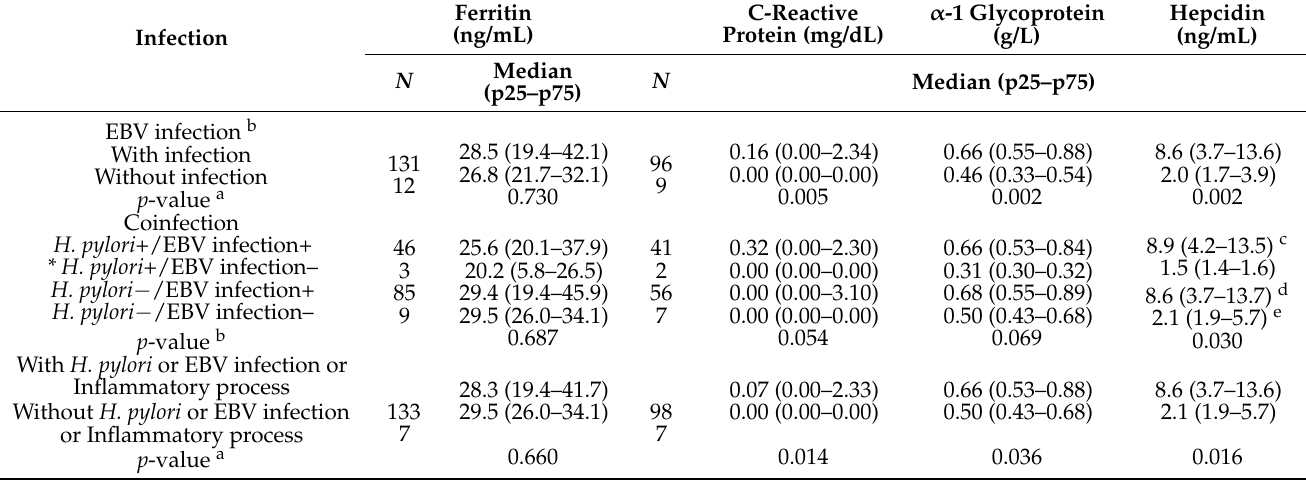
Figure 1). The ferritin concentration was not different. Hepcidin, CRP, and AGP levels were higher in EBV carrier children, and/or with H. pylori infection and/or in children with an inflammatory process, than in children non-infected or without an inflammatory pro- cess. Figure 2 shows that all the markers measured of EBV infection: VCA-IgG (R = 0.302, p < 0.001), EBNA1-IgG (R = 0.244, p = 0.011), and EA-IgG (R = 0.345, p = 0.011) had a positive correlation with the hepcidin concentration. We did not see significant correlations between EBV antibodies and CRP and AGP. The only other positive correlation was between AGP and hepcidin (R = 0.188, p = 0.047; not shown). Table 3. Acute-phase proteins concentration and infection with EBV or coinfection with EBV and H. pylori .